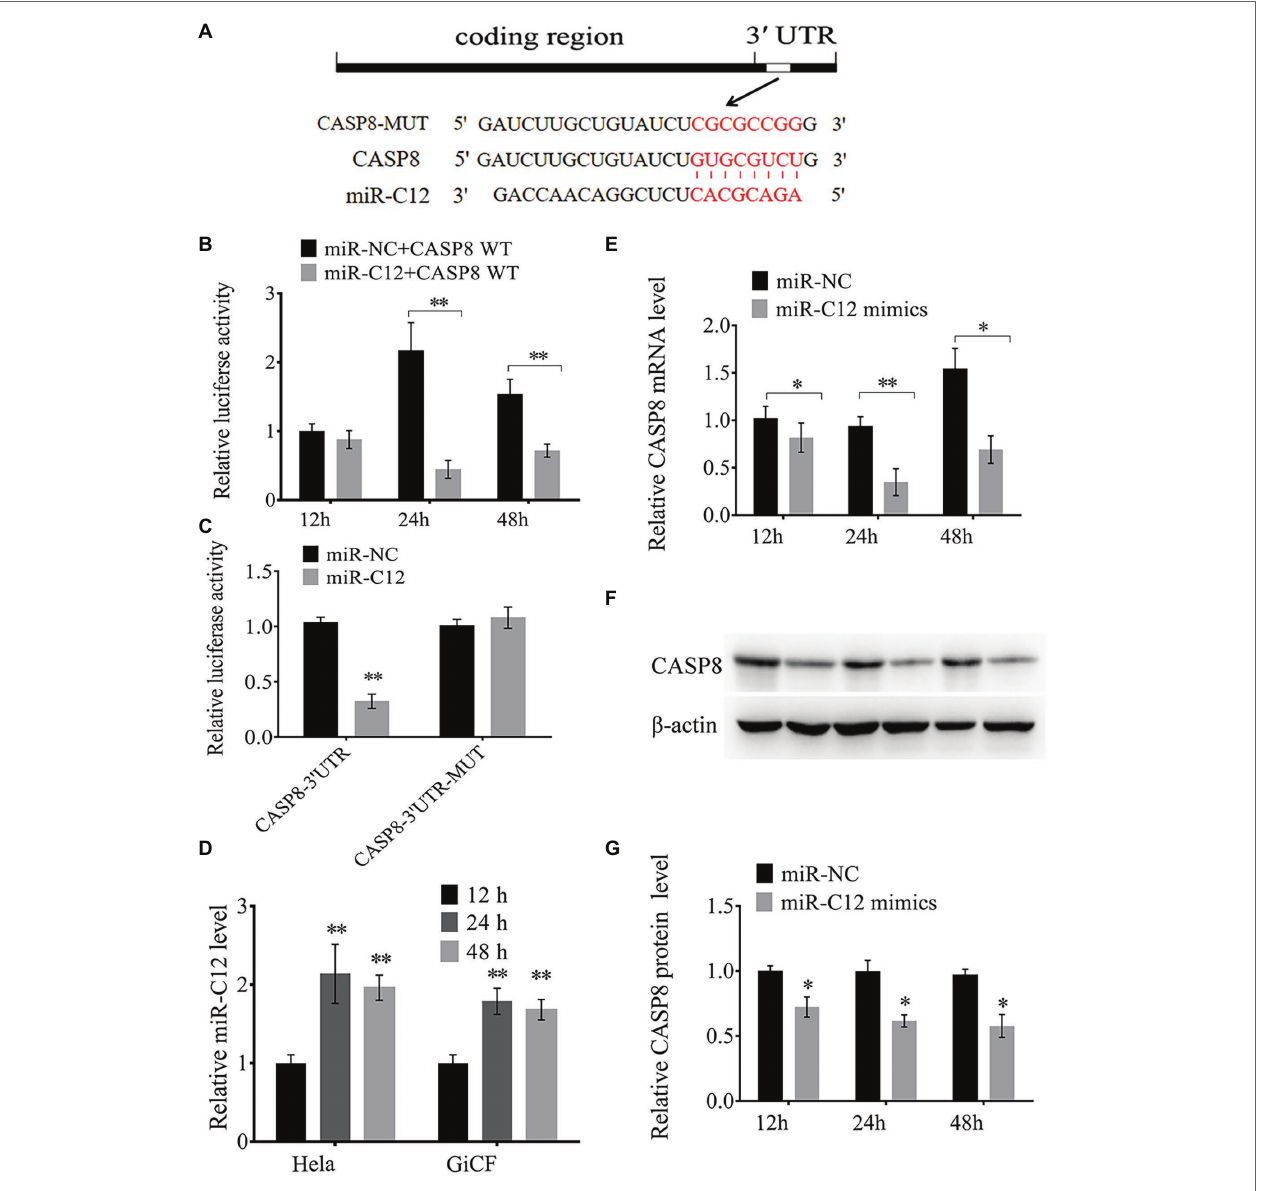
FIGURE 2 | miR-C12 directly targets the 3 ′ UTR of caspase 8 mRNA. (A) Sequence of putative binding site of miR-C12 within 3 ′ UTR of CASP8 mRNA. Mutations were introduced to the binding site. (B) HeLa cells were co-transfected with miR-C12 mimics or control miRNA and CASP8-WT. Following 12, 24, and 48 h post- transfection, luciferase activity was determined. (C) HeLa cells were transfected with miR-C12 mimics or control miRNA, together with CASP8-WT or CASP8-MT. Luciferase activity was determined 24 h post-transfection. (D) Relative expression level of miR-C12 post-transfection of miR-C12 mimics in HeLa cells. (E) The effect of miR-C12 on endogenous CASP8. GiCF cells were transfected with miR-C12 mimics or miR-NC, the expression level of CASP8 was determined by real- time qRT-PCR and Western blot (F) at 12, 24, and 48 h post-transfection. (G) Bar graphs displaying the CASP8 protein level. Data were represented as the means ± SD of three independent experiments performed in triplicate. ** p < 0.01; * p <